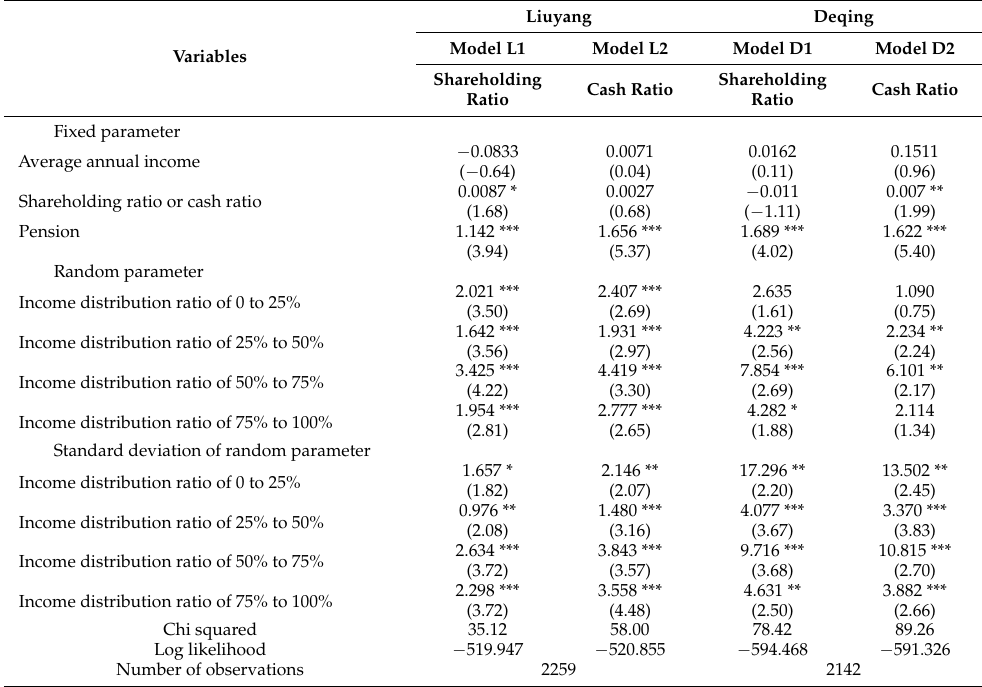
Table 6. Random parameter Logit model estimation results based on group samples under different income distribution